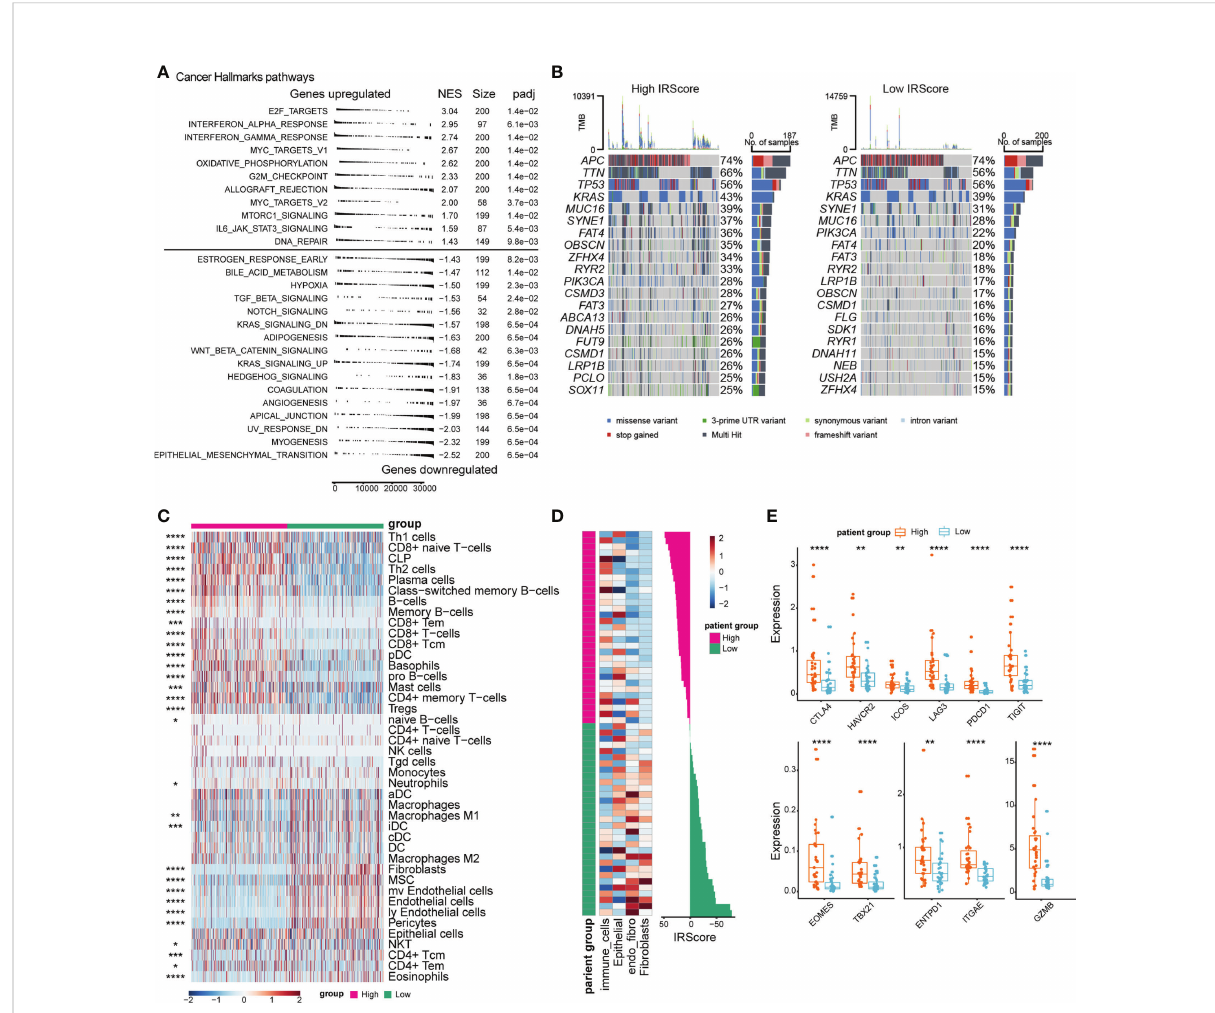
FIGURE 3 Comparison of transcriptomic pro fi le, genomic alteration and immune in fi ltration between high and low IRScore groups. (A) Gene set enrichment analysis of Cancer Hallmark gene sets identi fi ed signi fi cantly enriched pathways in high and low IRScore groups. (B) Oncoplot showing the top 20 most frequently mutated genes in high and low IRScore groups in TCGA cohort. (C) Abundance of different cell types in high and low IRScore groups was estimated by xCell in TCGA cohort. Z-scored results were depicted in heatmap. (D) Abundance of different cell types in high and low IRScore groups in the single-cell dataset GSE178341. Z-scored results were depicted in heatmap (left). Waterfall plot illustrating IRScore of each patient according to high and low groups (right). (E) Box plots showing the expression level of indicated genes in the two IRScore groups. *P < 0.05, **P < 0.01, ***P < 0.001,****P <